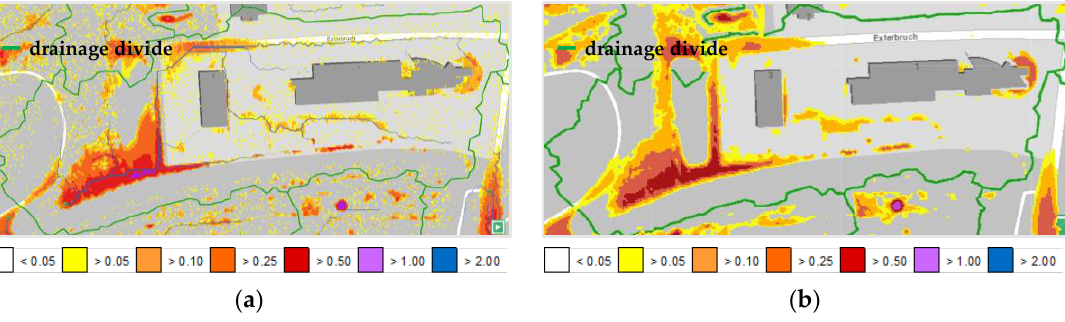
Figure 5. Predicted flood extent and depth after the precipitation: ( a ) reference flood map [30]; ( b ) simulation using the Roe solver with the suggested roughness values in the literature.